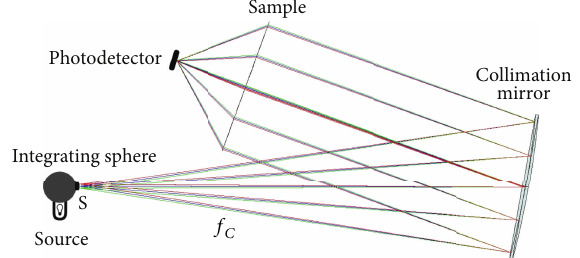
Figure 3: Scheme of set-up L1 (for image tests and focused image meas. on large components).